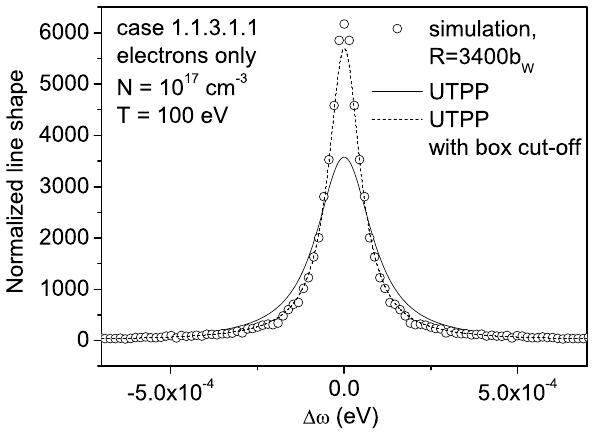
Figure 1. Hydrogen Lyman (cid:11) line shape calculated according to the subcase 1.1.3.1.1. The three plots correspond to (i) the result of the model assuming a finite box size R (dashed line); (ii) the model assuming infinite R (solid line); and (iii) a numerical simulation (circles). The second plot (solid line) serves as a reference. Keeping finite R results in an underestimate of the line width.